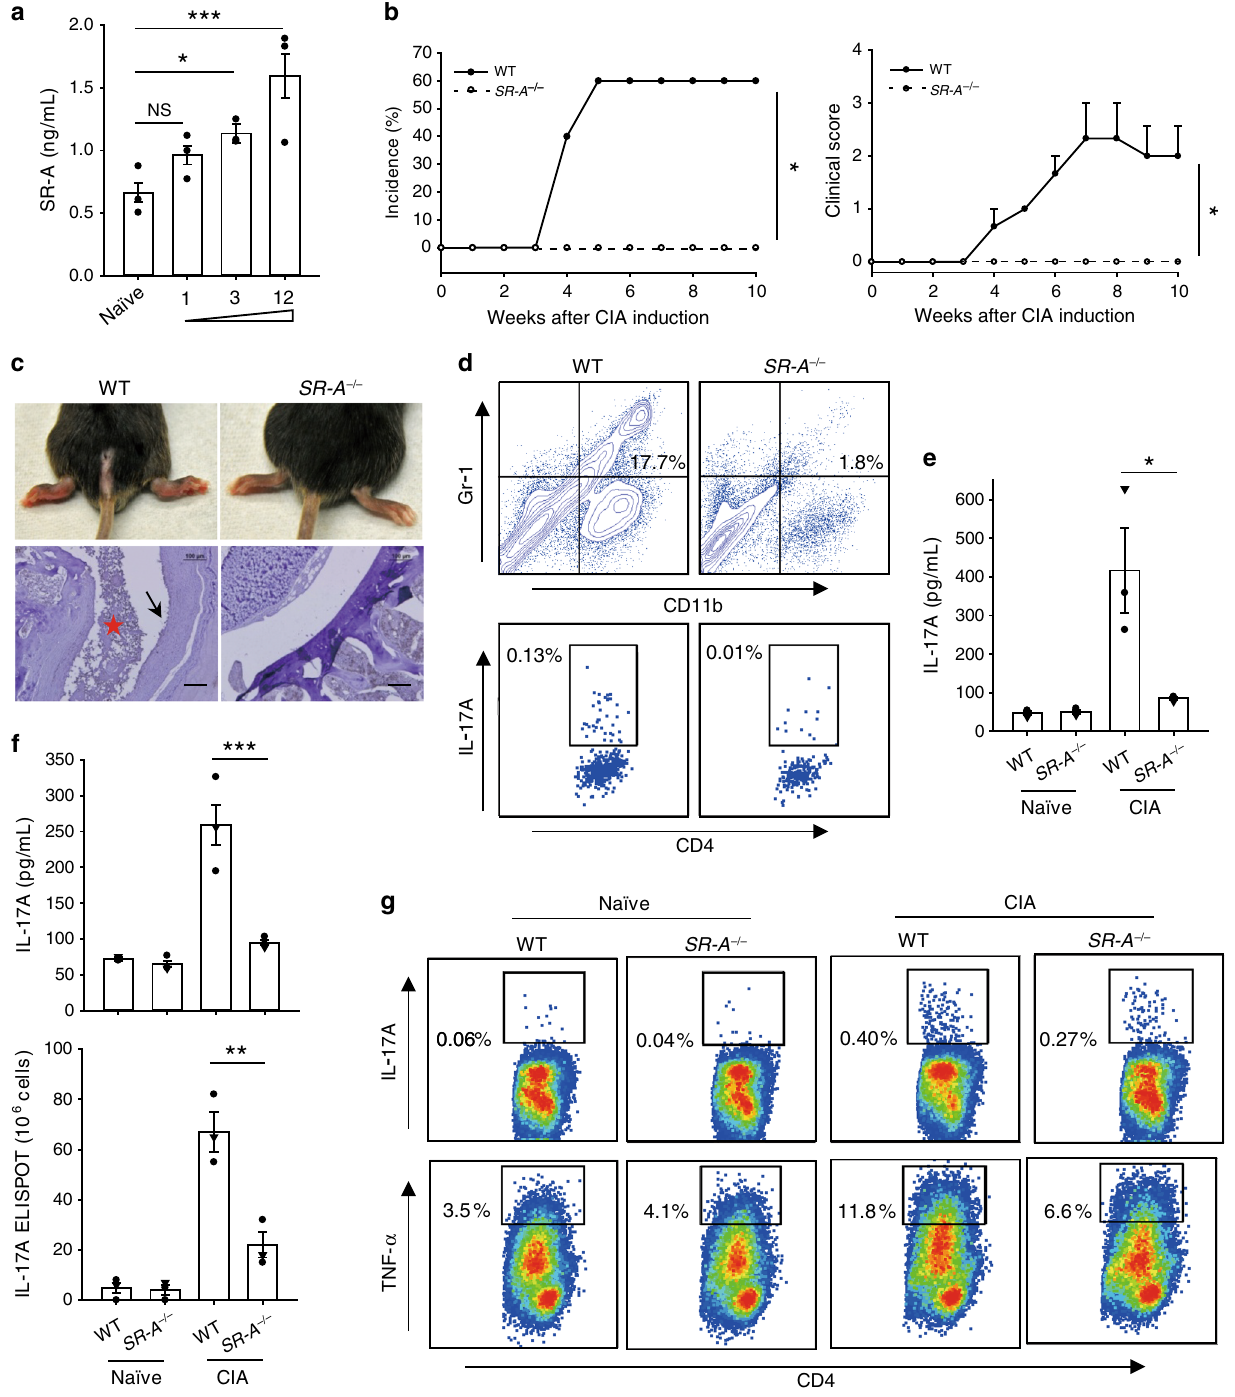
Fig. 7 Reduced incidence of CIA and autoimmune in fl ammation in SR-A- de fi cient mice. a The serum levels of mouse sSR-A in naïve C57BL/6 mice or CIA mice with different clinical scores were examined by ELISA ( n = 3 per group, * p = 0.0155, *** p = 1.7785E − 05). b Male WT ( n = 5) and SR-A − / − ( n = 5) mice were immunized with 200 μ g chicken collagen II emulsi fi ed in CFA. The arthritis incidence (* p = 0.049) and disease severity (* p = 0.0171) were followed. c Representative gross image of arthritis symptoms was recorded at 6 weeks post immunization. In fl ammatory cell in fi ltration and bone erosion were evaluated by H&E staining. Red star indicates in fl ammatory cell in fi ltration. Arrow indicates bone erosion. Scale bar = 100 μ m. d The in fi ltration of MDSCs and Th17 cells into the in fl amed joints was determined by fl ow cytometry. e Six weeks after CIA induction, serum level of IL-17A in the arthritic mice ( n = 3 per group, * p = 0.0387) was determined by ELISA. f – g Splenocytes from naïve or CIA WT/ SR-A − / − mice were cultured in the presence of denatured collagen (50 μ g/mL) for 48h. IL-17A levels in the culture medium were determined by ELISA ( f , top, *** p = 1.5376E − 04). Frequencies of IL-17A-producing cells were evaluated by ELISPOT ( f , bottom, ** p = 0.0085) or intracellular cytokine staining ( g , top). The frequencies of TNF- α -producing CD4 + T cells upon collagen stimulation were also assayed by intracellular cytokine staining ( g , bottom). Data are presented as mean±SEM. Results are representative of three independent experiments. * p <0.05, ** p <0.01, *** p <0.001, NS, not signi fi cant (one-way ANOVA test followed by Dunnett ’ s posttest for multiple comparisons a , LogRank test and two- way repeated measures ANOVA test b , or two-tailed Student ’ s t test e and f ). Source data are provided as a Source Data fi